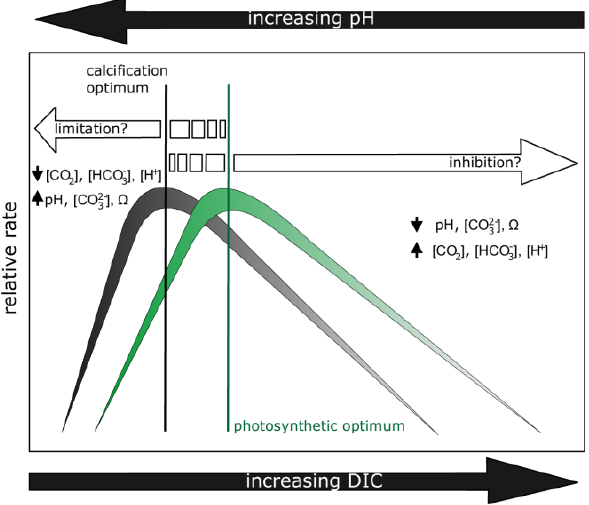
Fig. 3. Conceptual model of coccolithophorid photosynthesis and calcification in response to changes in carbonate chemistry specia- tion due to increasing DIC at decreasing